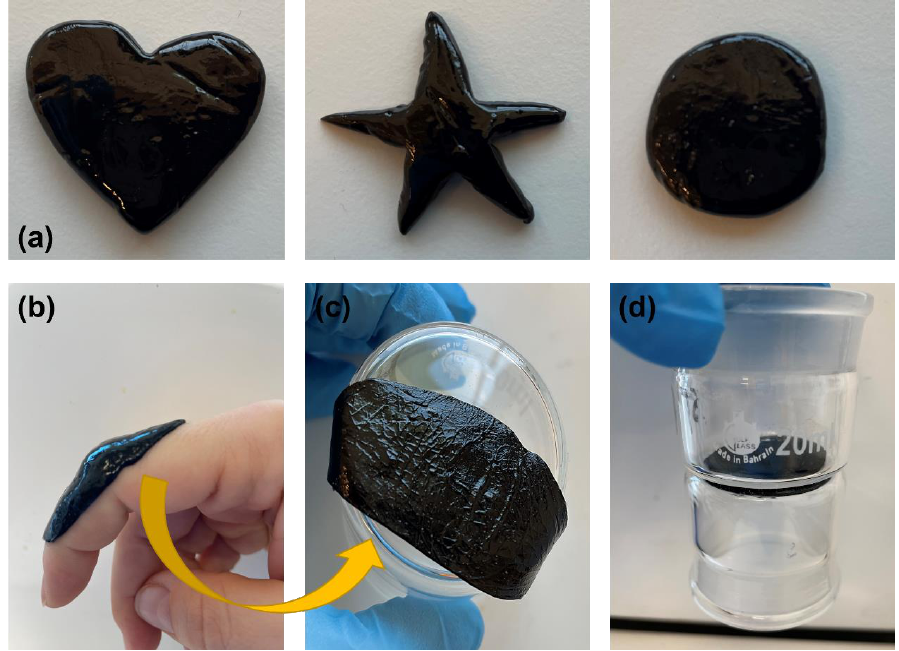
Figure 8. ( a ) Moldability of samples into different shapes, ( b ) self-adhesion on skin, ( c ) morphology of the hydrogel contact surface with the skin, and ( d ) example of adhesion to